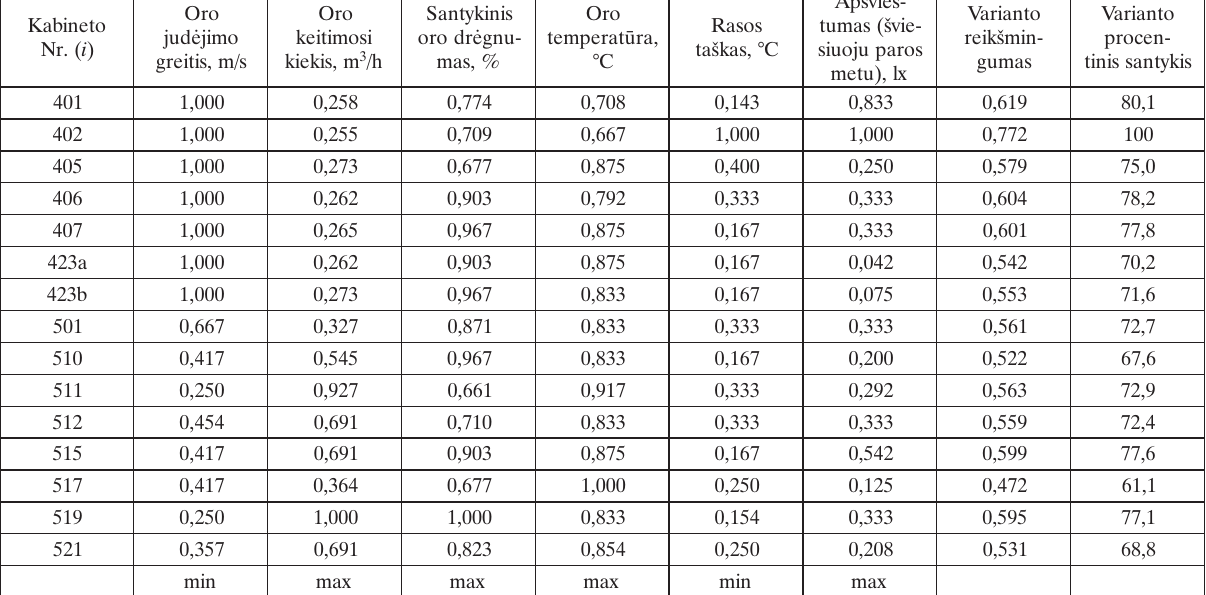
Table 3. Normalised data otenibaK (.rN i